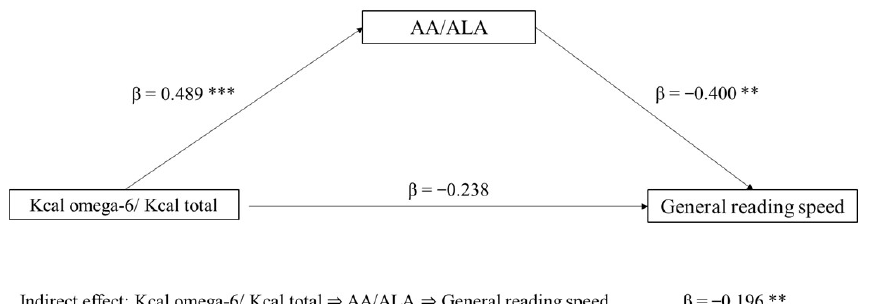
Figure 1. Mediation model with general reading speed (z-score) as the dependent variable, Kcal omega-6/Kcal total as the independent variable, and AA/ALA ratio as mediator (** p < 0.05, *** p < 0.001, one-tailed). The figure shows direct and indirect (component) effects. Betas are completely standardized effect sizes.